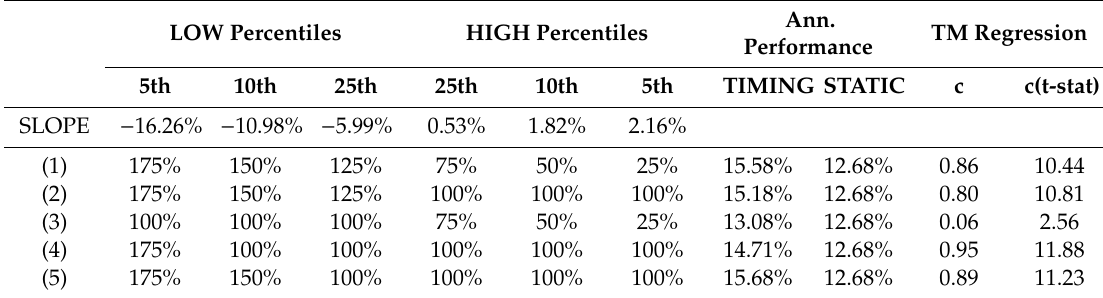
Table 4. Results from investment strategies (weights in stocks are displayed in the first six columns) which uses the slope of the equity curve to over- / under-weigh stocks. LOW Percentiles HIGH Percentiles